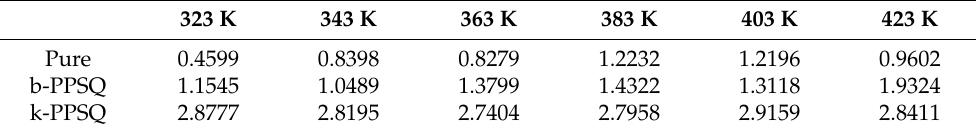
Table 2. Cauchy pressure of the two blending models at different